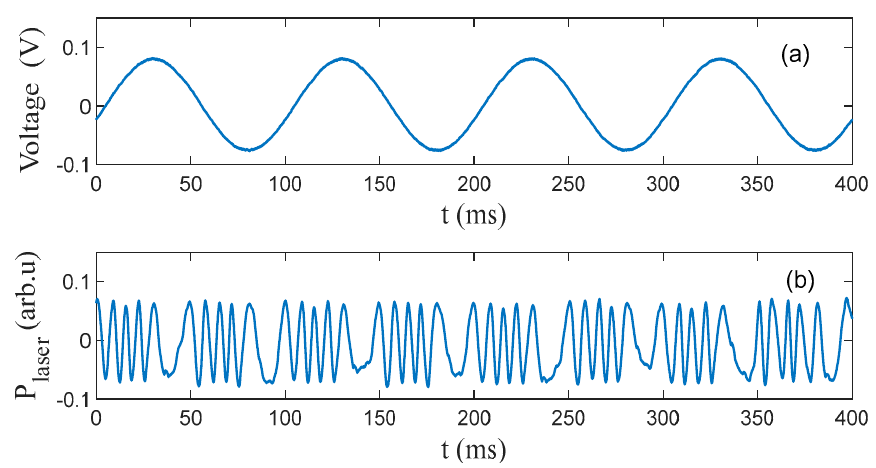
Figure 5. Experimental results of the LFI signal corresponding to in-plane displacement Δ x (8000 nm p–p). ( a ) The voltage obtained from the sensor monitor corresponding to displacement Δ x . ( b ) Experimental LFI signal.